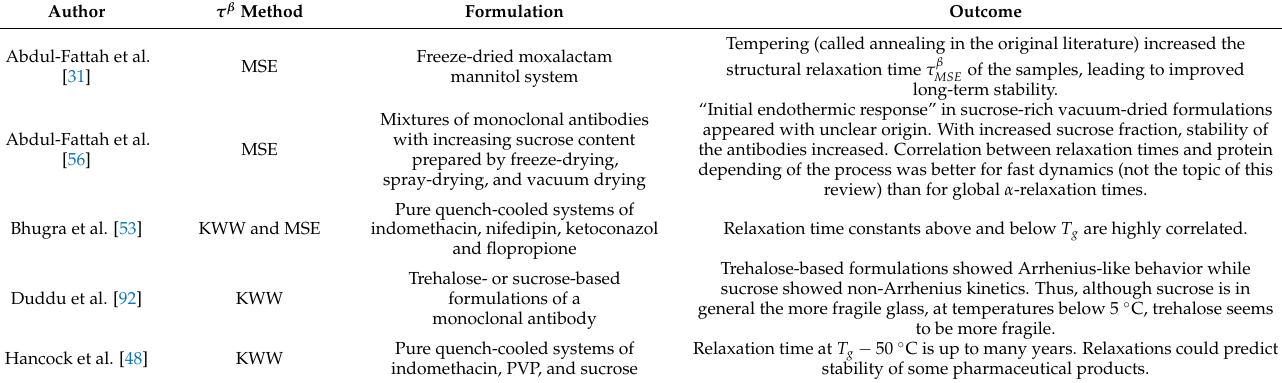
Table A2. Collection of performed relaxation measurements by different